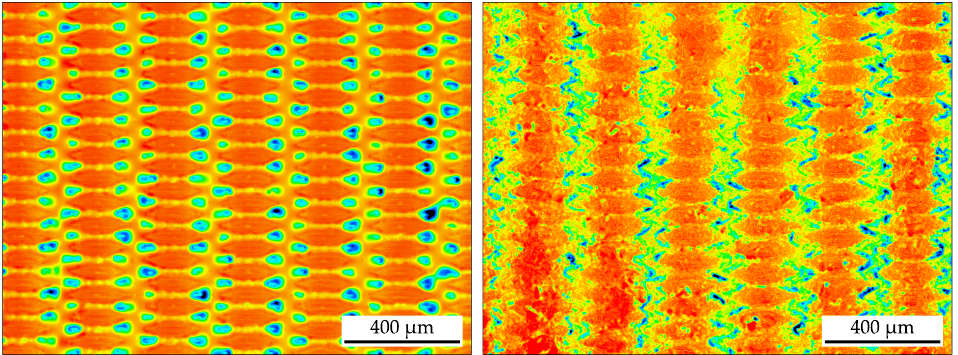
Figure 9. Laser scanning microscope images. Surface profile of an unused ( left ) and a used ( right ) filter cloth. It is noticeable the original surface including the pore structure is still visible when used, so that the influence of the contaminations is negligible.